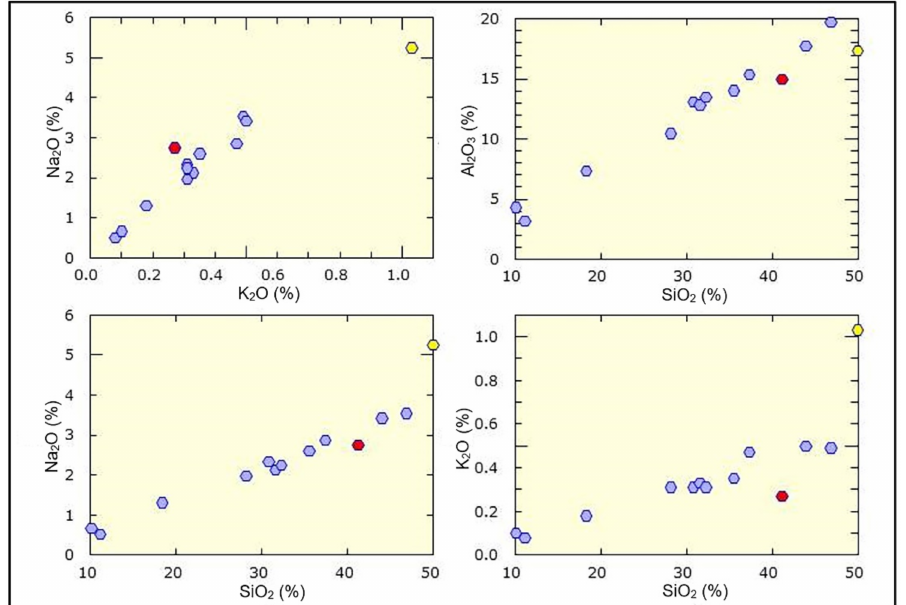
Figure 6. Mobile oxide variation diagrams for samples from hole VB95-129; the anorthosite sample (5.06–5.15 m) is yellow, the gossan sample (3.4–3.48 m) is red, and the remaining samples are blue.